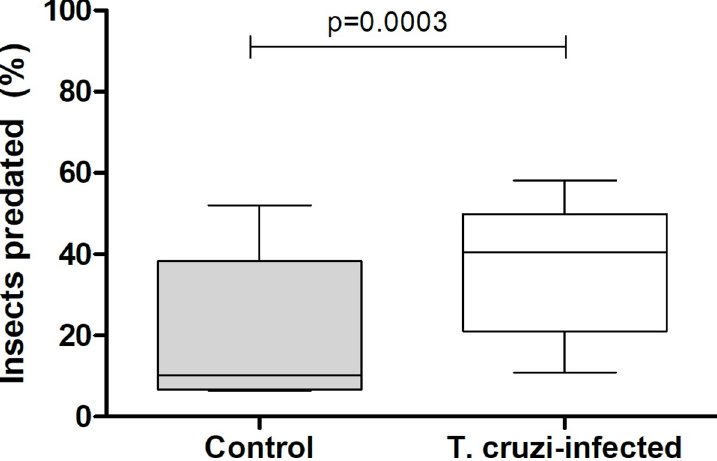
Fig 2. Percentage of Trypanosoma cruzi -infected and uninfected Rhodnius prolixus nymphs which were predated during the 16 h of exposure to a mouse. Data depicted represent the median (horizontal line) of the percentage of predated insects from five independent assays (25% - 75%, Max—Min).